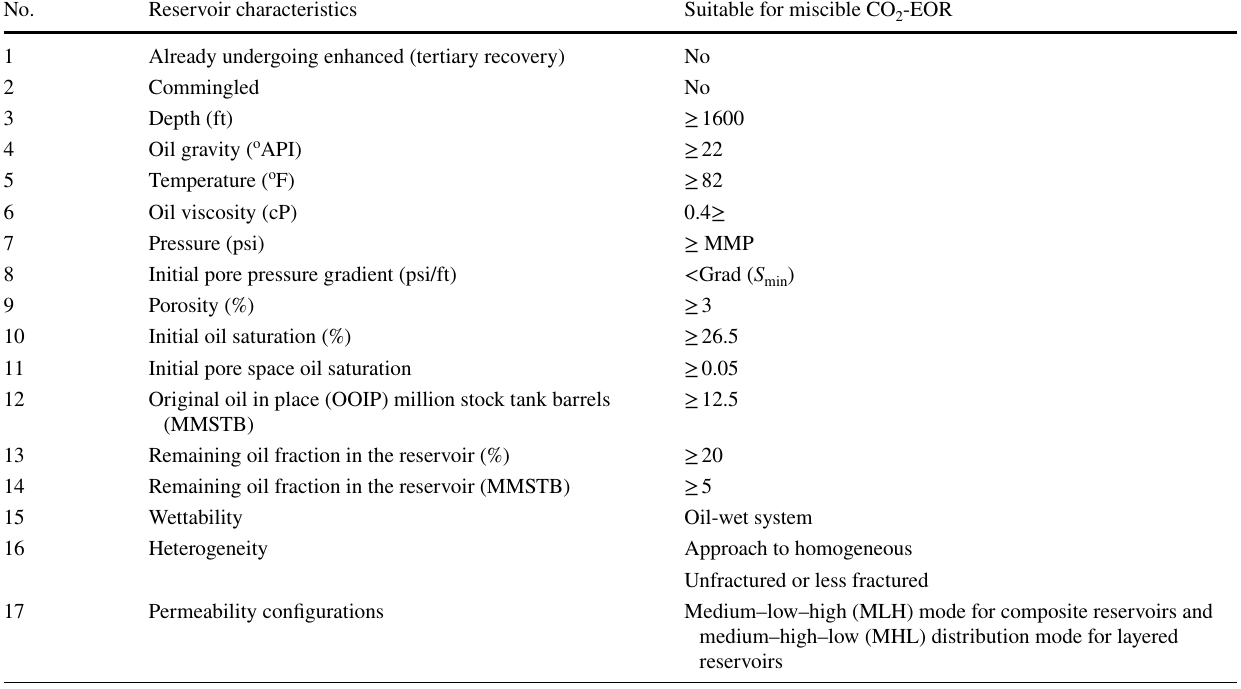
Table 4 The criteria proposed by Bachu (2016) and modified by adding parameters in Sr. 15–17 to screen oil reservoirs for miscible CO